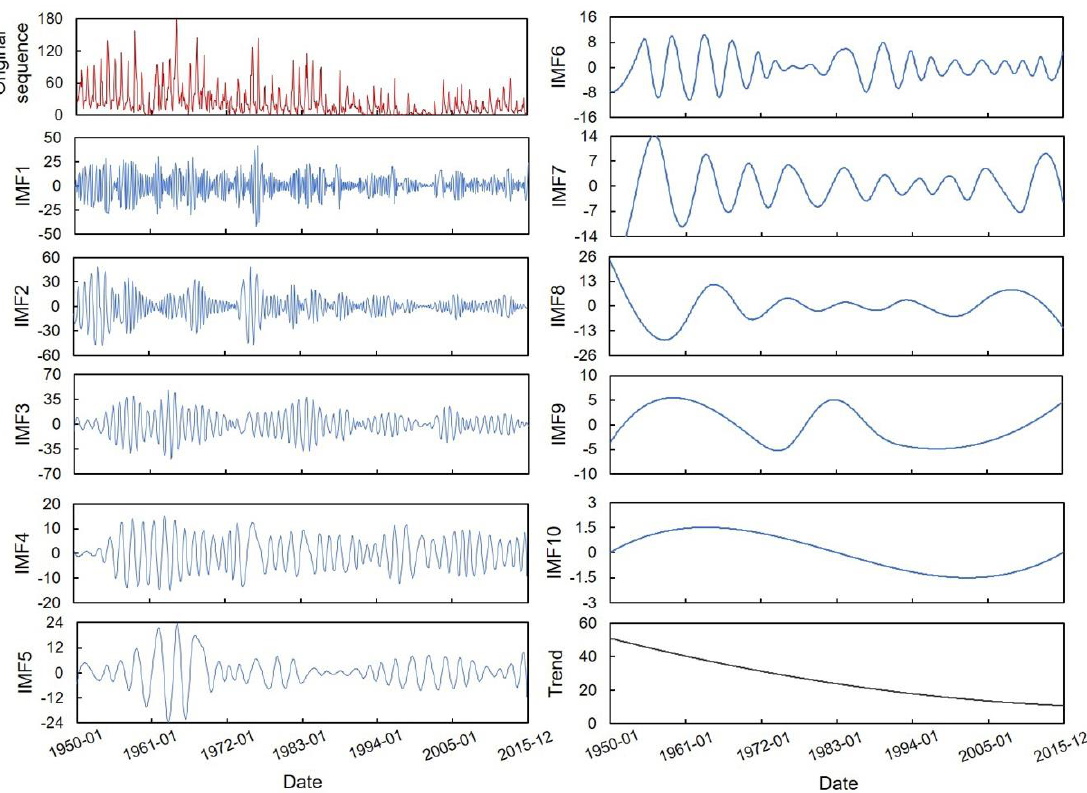
Figure 12. Empirical mode decomposition for the 66 a series of LHS.